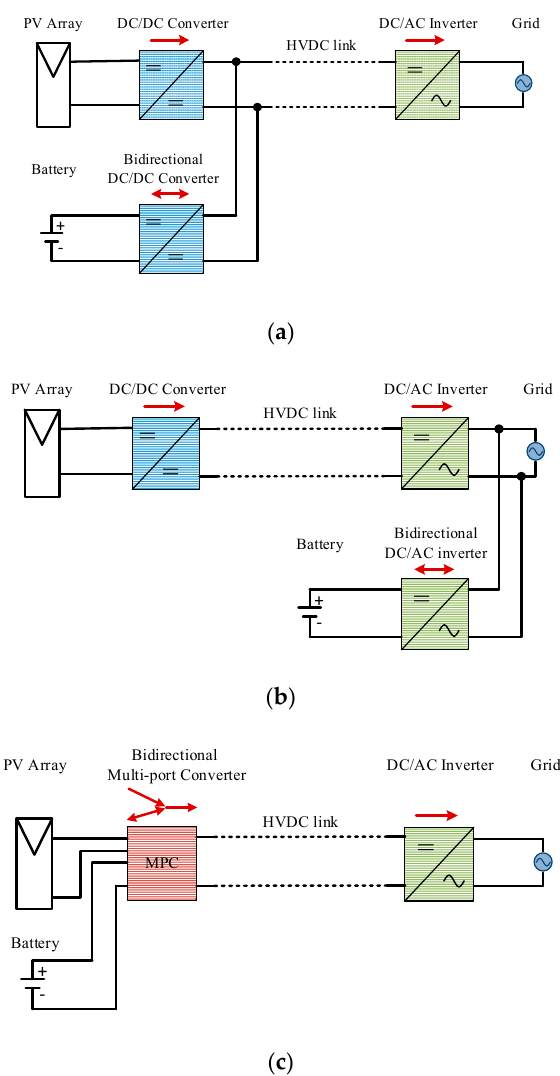
Figure 1. Main configurations for integrating energy storage (ES) system and high voltage direct current (HVDC) system: ( a ) dual-converter architecture; ( b ) dual-inverter architecture; ( c ) multi-port converter architecture.